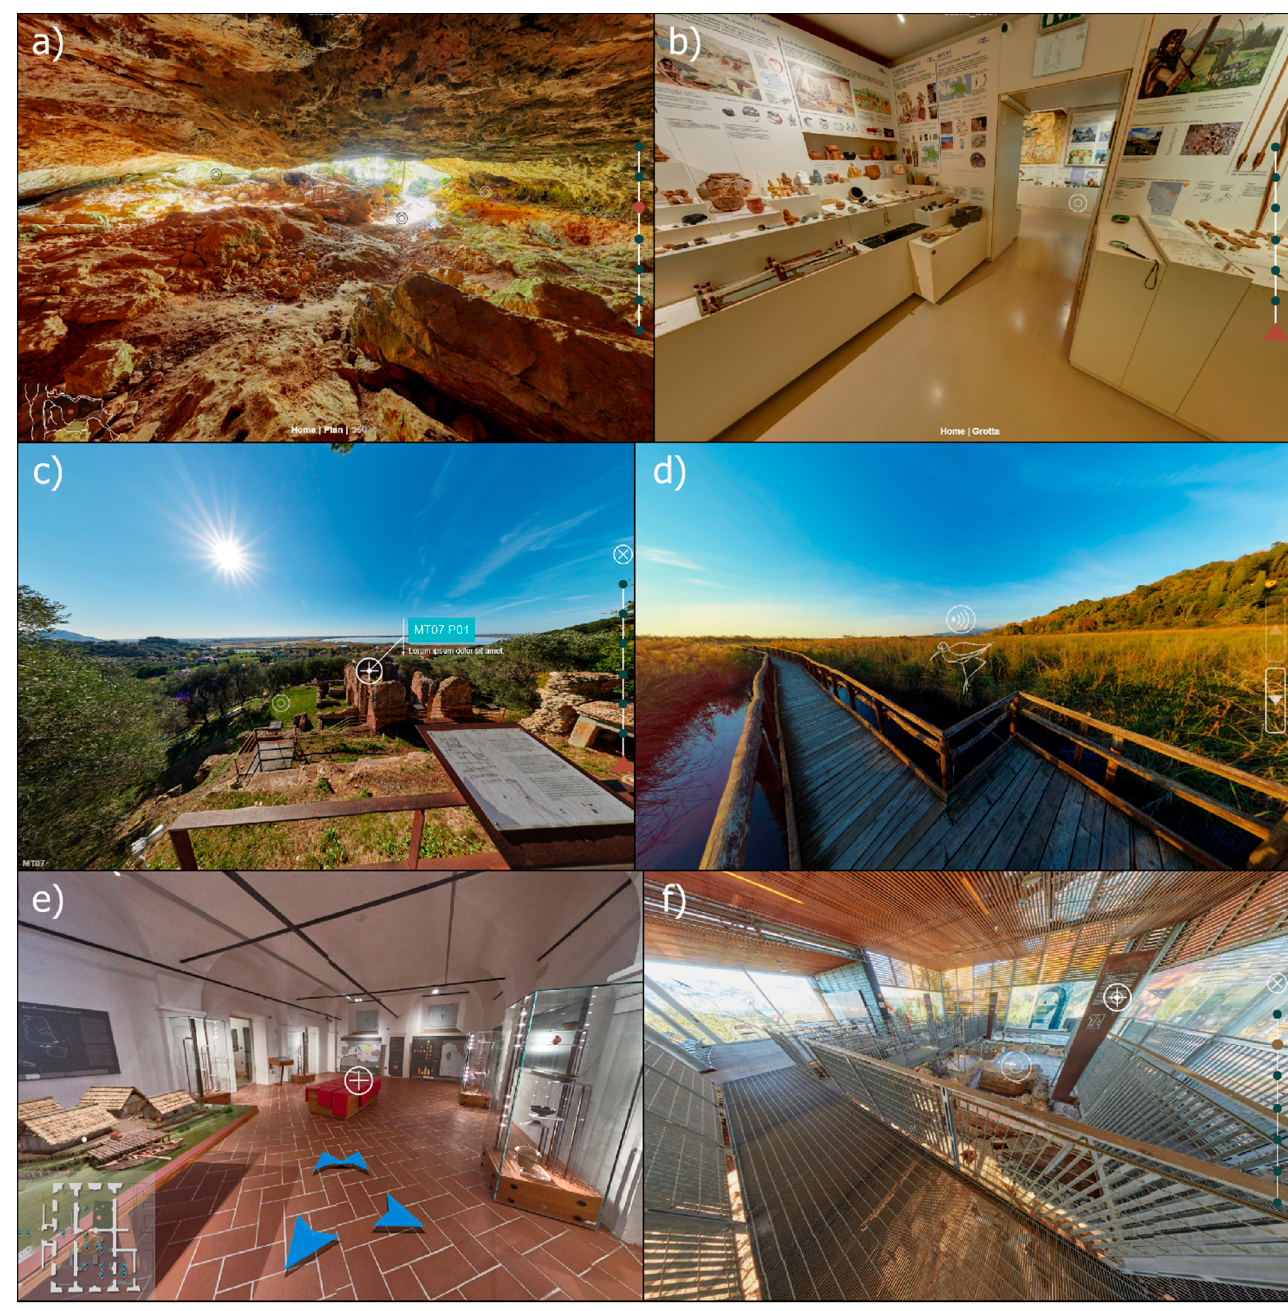
Figure 5. Some 360° images used to create the virtual tours: a) Grotta all’Onda; b) Museo Archeologico Camaiore; c) Figure 5. Some 360 ◦ images used to create the virtual tours: ( a ) Grotta all’Onda; ( b ) Museo Archeo- Massaciuccoli Domus from a viewpoint; d) Oasi Lipu; e) Museo Archeologico Versiliese ‘Bruno Antonucci’ (Pietrasanta); logico Camaiore; ( c ) Massaciuccoli Domus from a viewpoint; ( d ) Oasi Lipu; ( e ) Museo Archeologico f) Massaciuccoli Terme. Versiliese ‘Bruno Antonucci’ (Pietrasanta); ( f ) Massaciuccoli Terme. The web application interface is composed of a toolbar on the left, a map in the centre and a menu on the right (Figure 6). The web application is available for consultation at the following link: http://tlweb.it/pantarei/gis (accessed on 11 May 2010). The toolbar is provided with some functions for the navigation, selection and management of the map. In the menu, the layer tree view in the menu permits to manage the layers, with the possibility of making them visible, moving them, downloading the dataset and viewing the style of the layers. By using the web application, it is possible to visit both the real and the virtual itineraries and to gain territorial as well as cultural